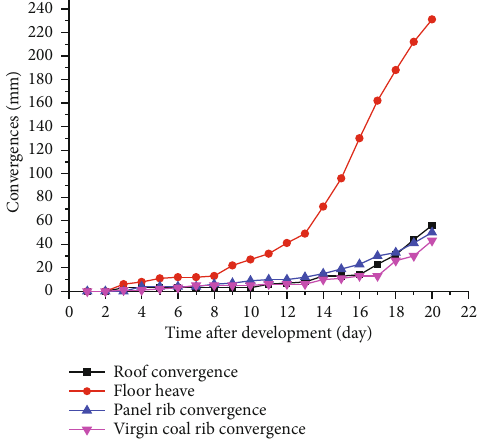
Figure 12: The relation between convergences and time.